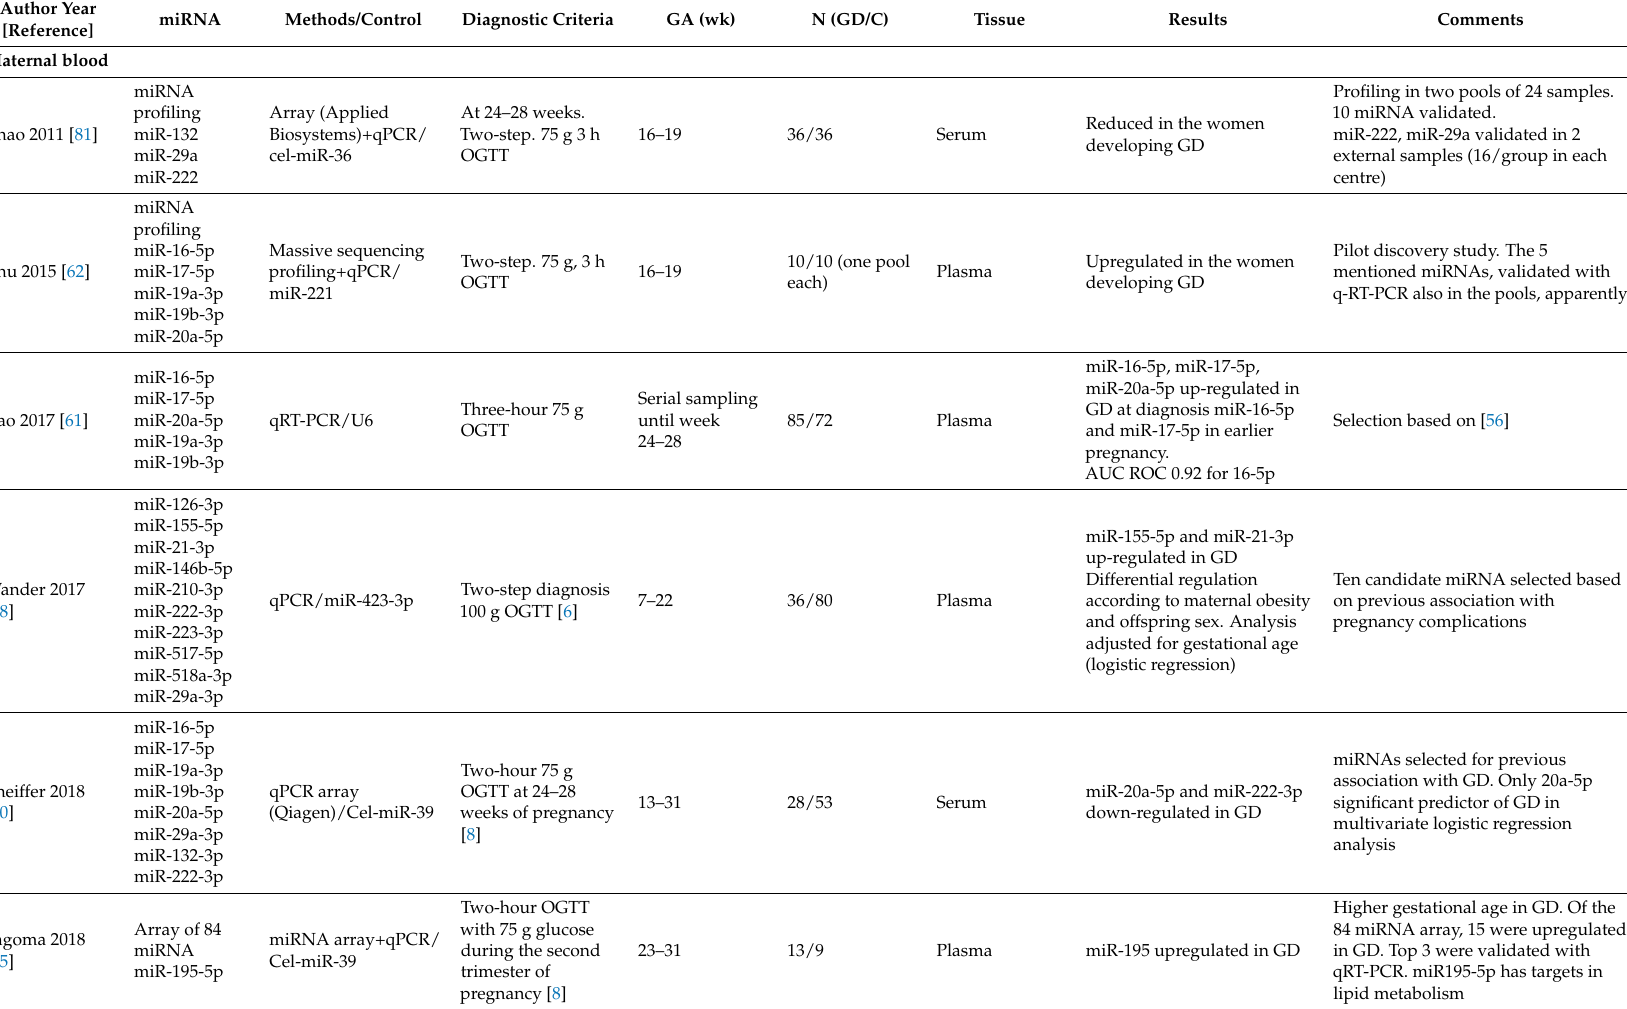
Table 2. Studies assessing the role of miRNAs in gestational diabetes (GD) and its